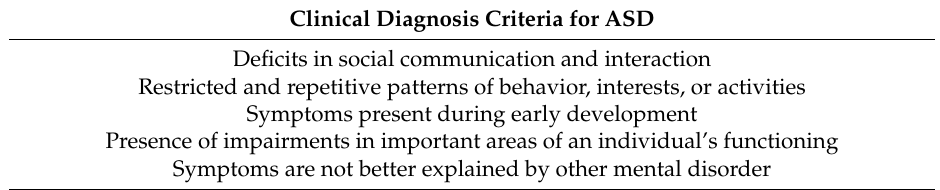
Table 1. Standard clinical criteria for the identification and diagnosis of ASD in the population according to the DSM-5